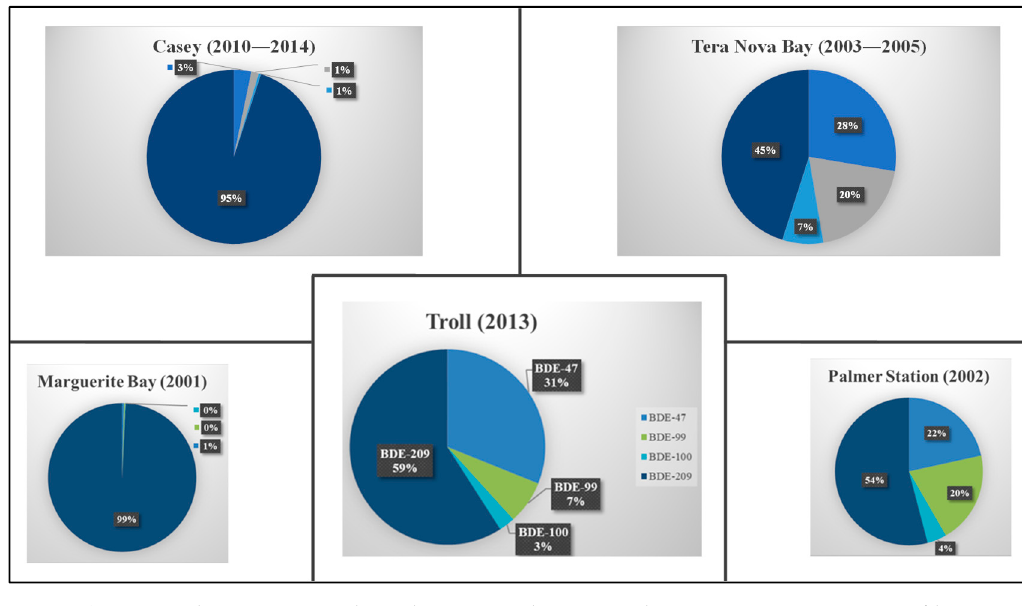
Figure 3. Relative congener homologue contributions to the respective station air profiles.